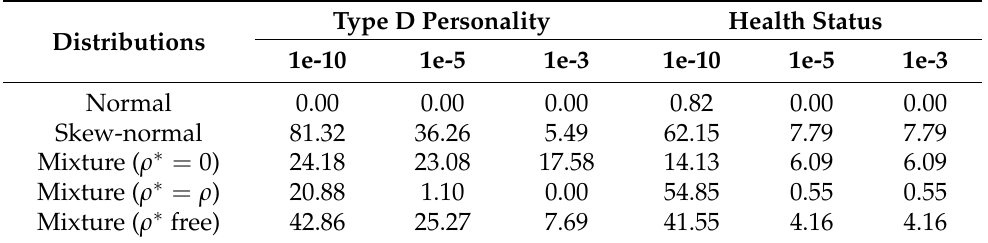
Table A1. Nonconvergence rates of each of the distributions under different relative